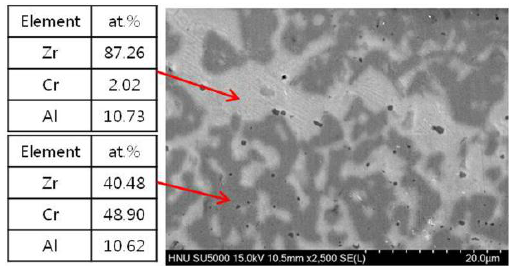
Figure 4. SEM-EDS analyses of Zr-rich area of CrAl-coated Zircaloy-4 alloy after the isothermal heating at 1100 °C for 2 h in inert atmosphere.